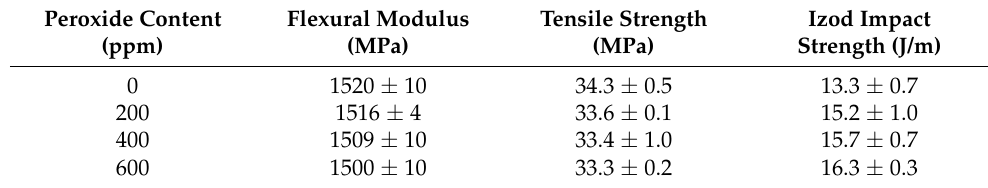
Table 2. Effect of peroxide content on mechanical properties of PPs such as flexural modulus, tensile strength, and Izod impact strength.